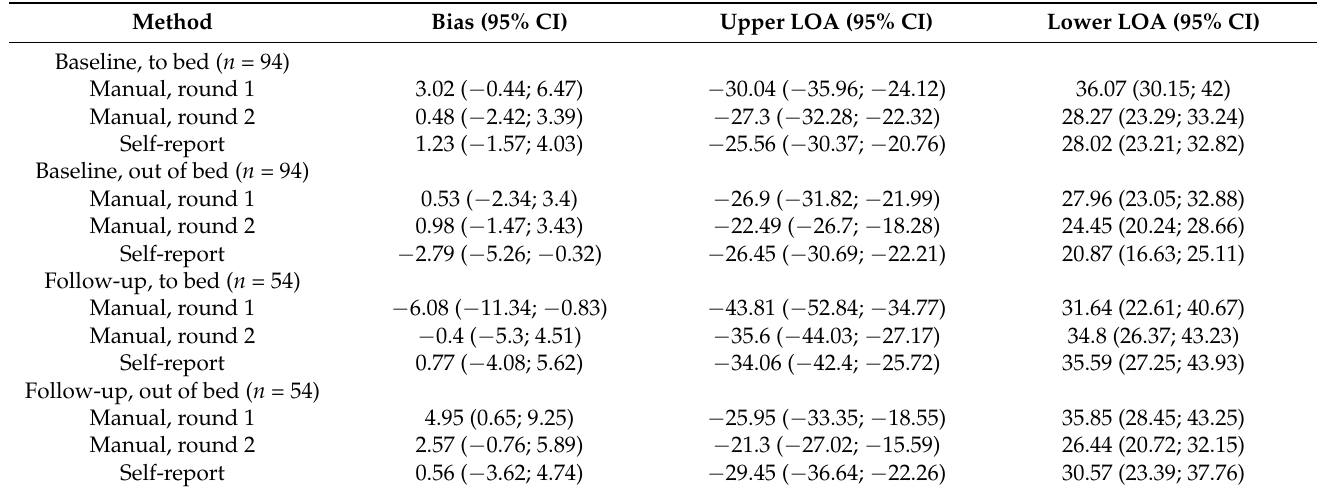
Table 7. Bland–Altman analysis of inter-method agreement between manual annotation and ZM as well as self-report and ZM. All estimates are in minutes.